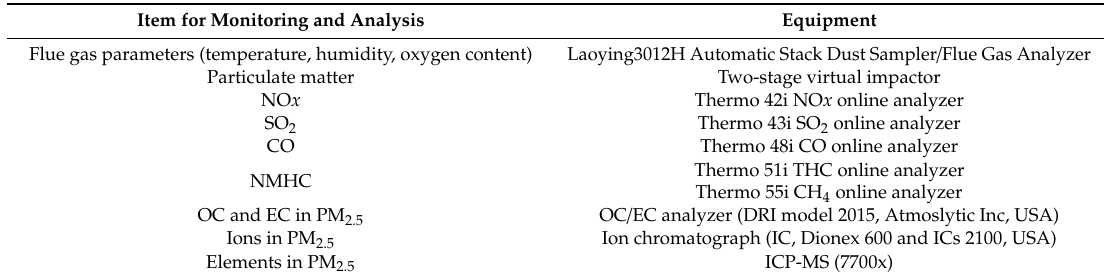
Table 1. Equipment used for sample collection and